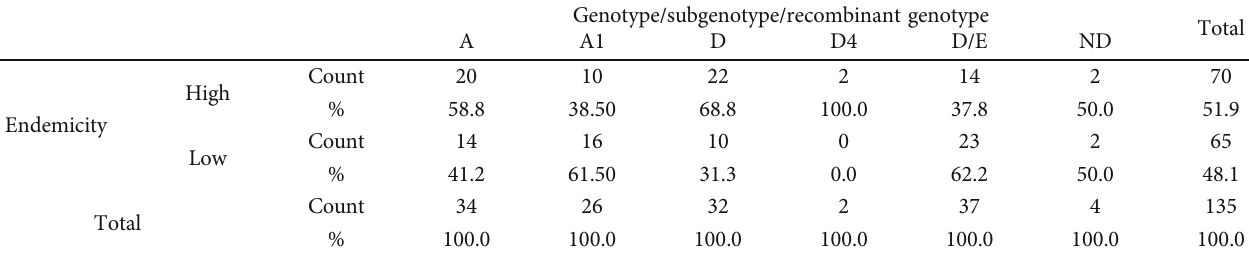
Table 2: Distribution of HBV genotypes and subgenotypes in the low and high endemic regions.